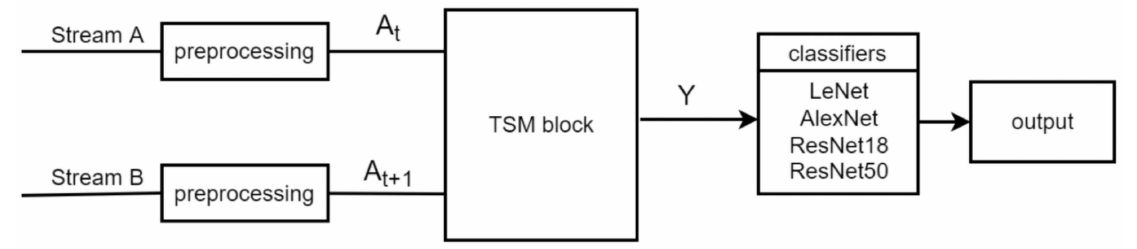
Figure 3. The overview of TSM-CNN. TSM